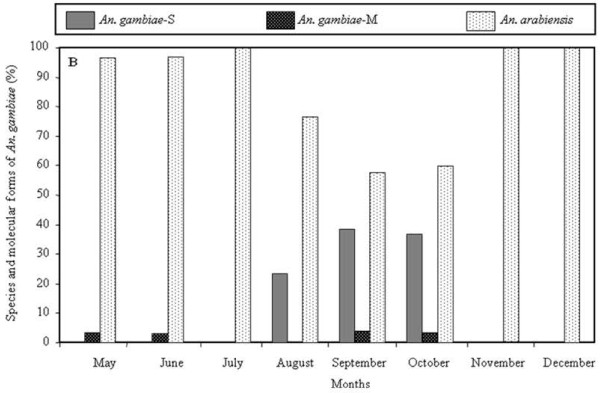
Monthly population dynamics ofAnopheles gambiae s.l.in Dioulassoba.